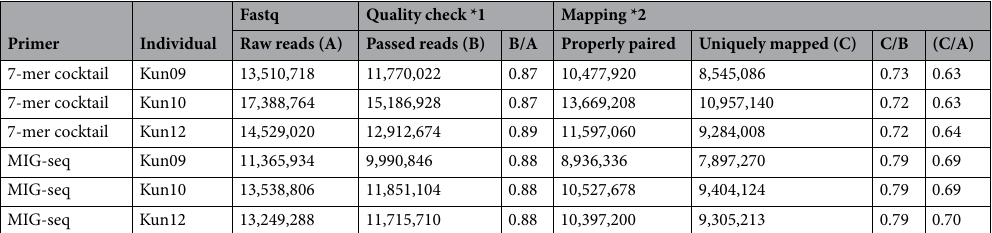
Table 2. Results of sequence quality filtering and mapping on the reference genome. *1: Primer sequences, Illumina adapters, and low-quality reads were trimmed. The phred score less than 15 for more than 40% bases, or a read with fewer than 15 bases. *2: Mapping on the reference genome was conducted using BWA mem. A summary of the mapped reads was obtained using SAMtools with the flagstat command.